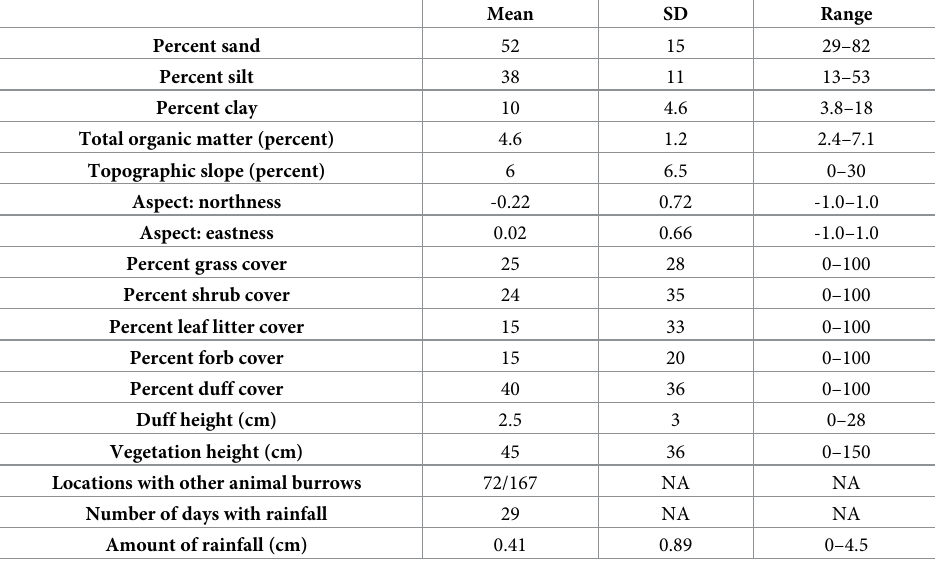
Table 2. Summary of characteristics at burrow locations and rainfall data for the winter of